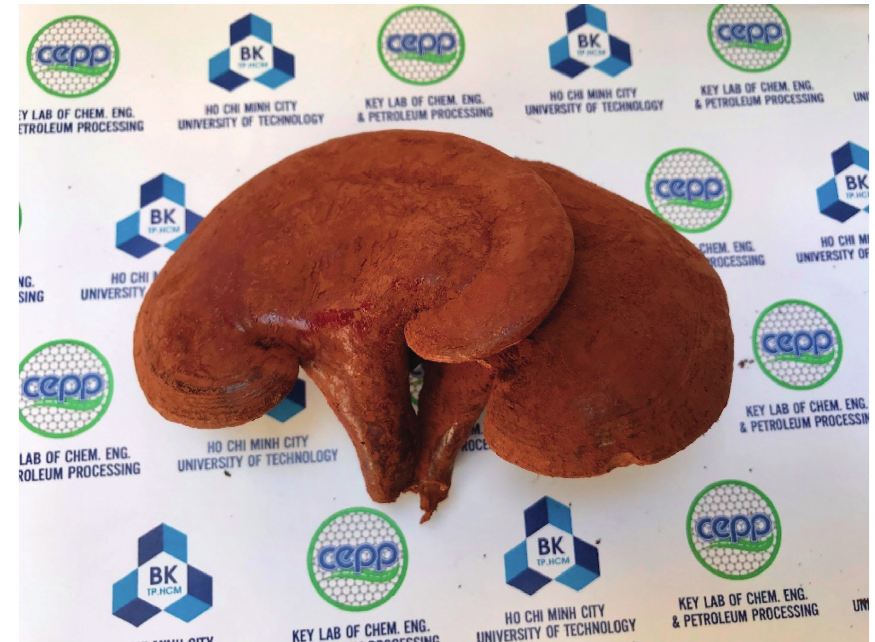
Figure 1: Image of Vietnamese red G. lucidum . Table 1: Independent variables and their